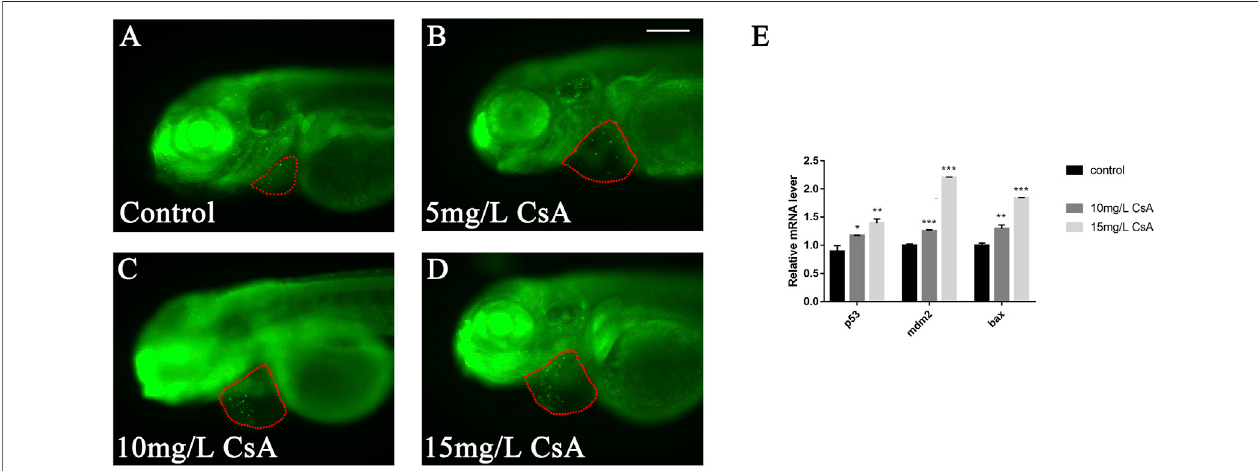
FIGURE 4 | CsA-induced apoptosis of zebra fi sh cardiomyocytes. (A-D) AO staining of heart of zebra fi sh embryos at 72 hpf exposed to 5 mg/L, 10 mg/L, and 15 mg/L CsA. The red dotted line indicated the heart area, and the green fl uorescent dots indicated apoptotic cells. (E) mRNA levels of apoptotic and anti-apoptotic genes in control group and 10 mg/L CsA treated group (Compared with control: * p < 0.05, ** p < 0.01, *** p < 0.001, mean ± S. D). Scale bars: 100 µm (A-D)